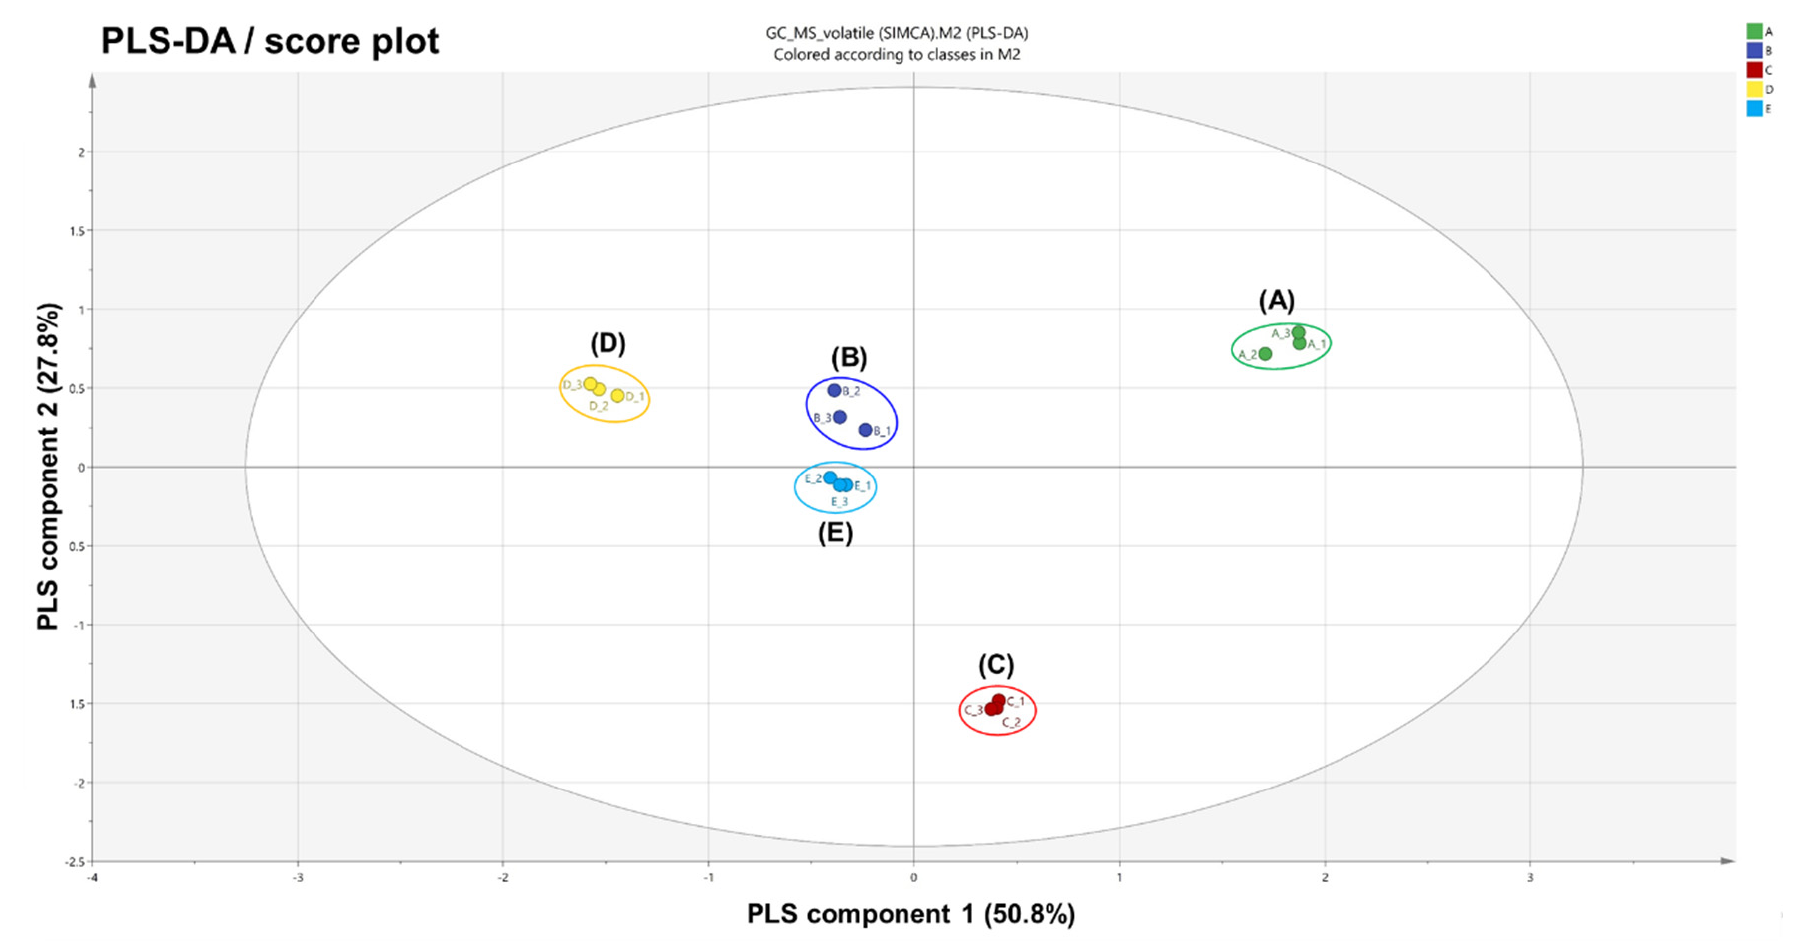
Figure 2. Partial least squares discriminant analysis (PLS-DA) score plot obtained from HS-SPME-GC-MS results on five variants of Abeliophyllum distichum flowers: ( A ) white miseon, ( B ) pink miseon, ( C ) ivory miseon, ( D ) blue miseon, ( E ) round miseon.